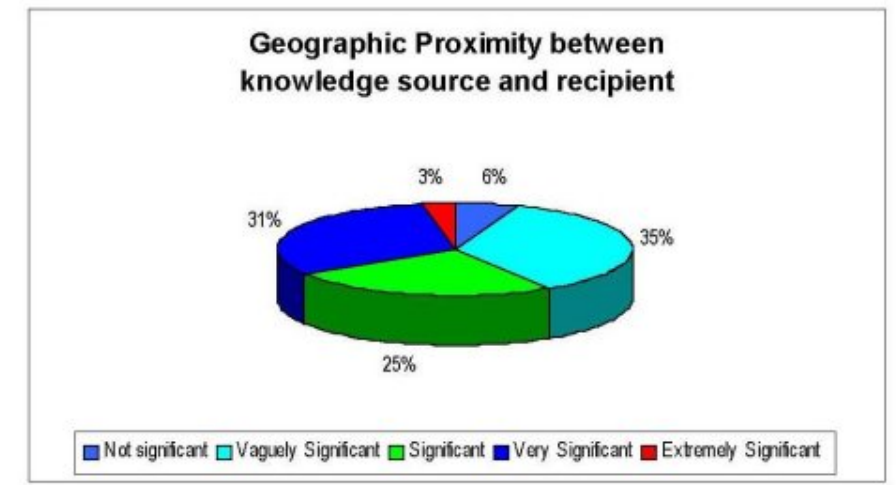
Figure 10 Respondent votes on geographic proximity between knowledge source and